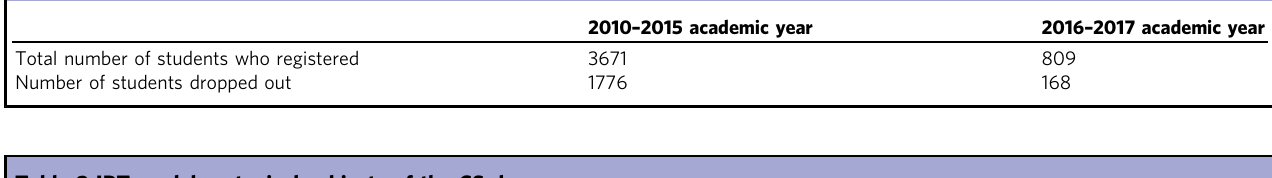
Table 2 IRT-model on typical subjects of the CS degree program.